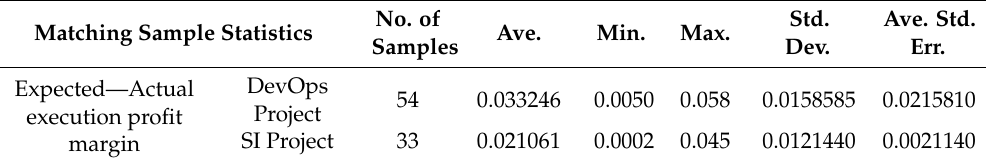
Table 9. Statistics of matching samples (expected profit margin–actual execution profit